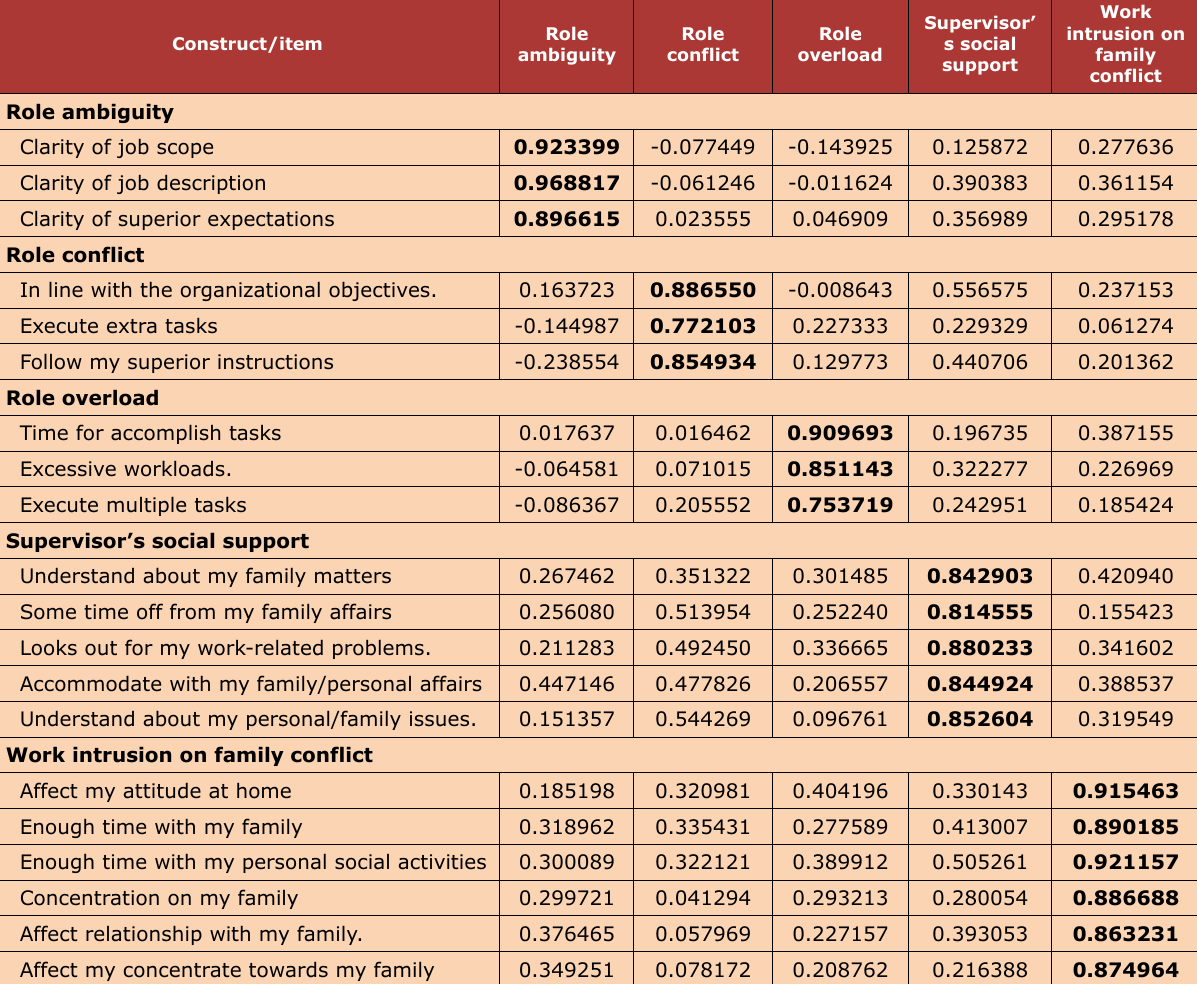
Table 3. The results of factor loadings and cross loadings for different constructs Table 4 shows the results of reliability analysis for the instrument. The composite reliability